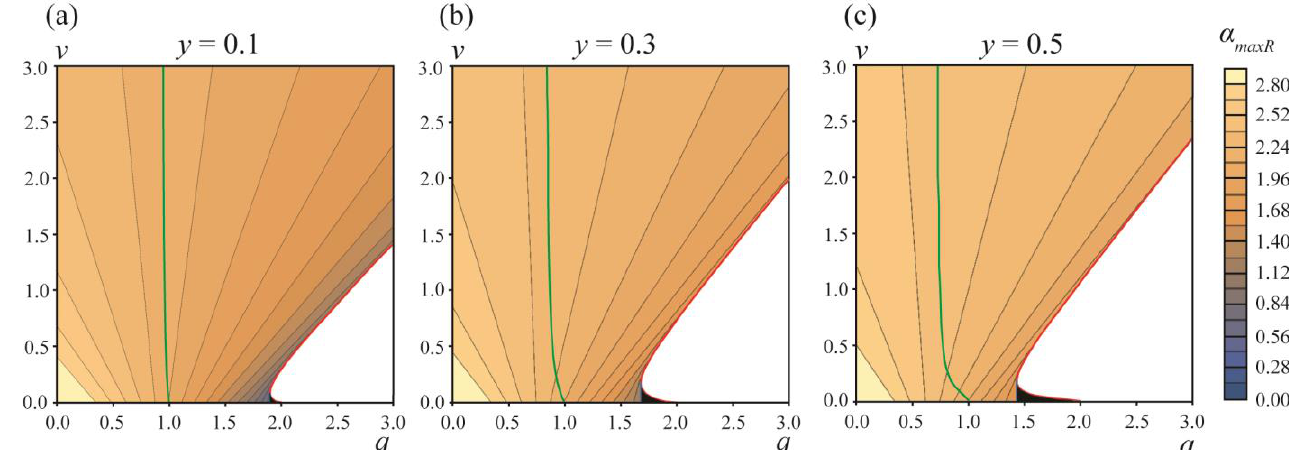
Figure 5. The dependence of the angle corresponding to the top of the energy barrier of two separate vesicles formation, α maxR , on the parameters q , v for area fractions of the A phase ( a )— y = 0.1; ( b )— y = 0.3; ( c )— y = 0.5. Green curves are right boundaries of the q , v parameter regions where W min = W eff ( α min ) ≤ 0. Red curves are the left boundaries of the q , v parameter regions where the formation of two separate vesicles is barrier-free (white zones in right bottom corners of the plots). Blue line is the left boundary of the q , v parameter region, where α > α maxR (black triangles near the point q ≈ 2, v ≈ 0).